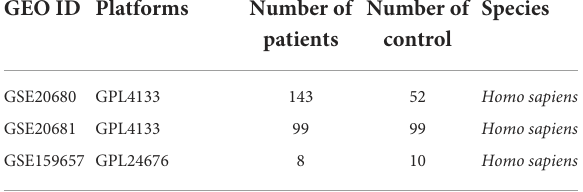
TABLE 1 The detailed information of the GEO data